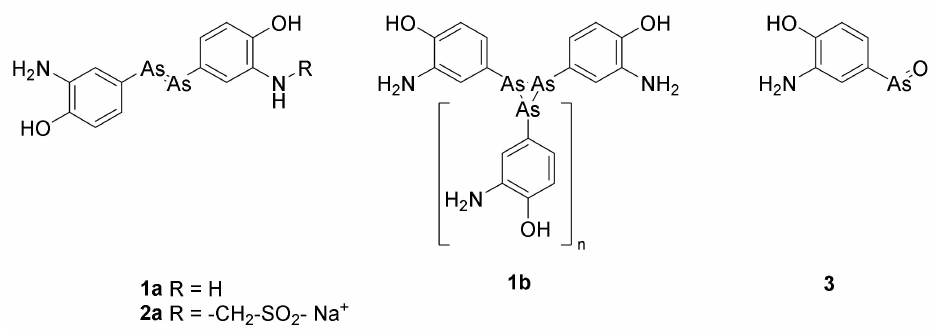
Figure 1. The commonly shown structure for arsphenamine (salvarsan) is 1a . Arsphenamine is now known to be a mixture of compounds with the formula 1b , in which n varies from 1 to 7. The predominant values are n = 1 and n = 3. Neosalvarsan ( 2a ) was designed to increase the solubility [18]. Oxphenarsine 3 is the expected active metabolite of arspehamine